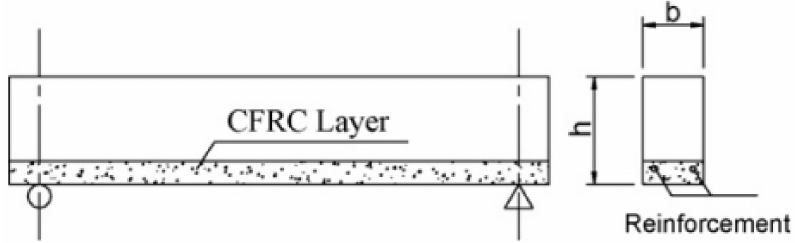
Figure 19. CFRC strengthened RC beam design. Reproduced with permission from [72], Elsevier,